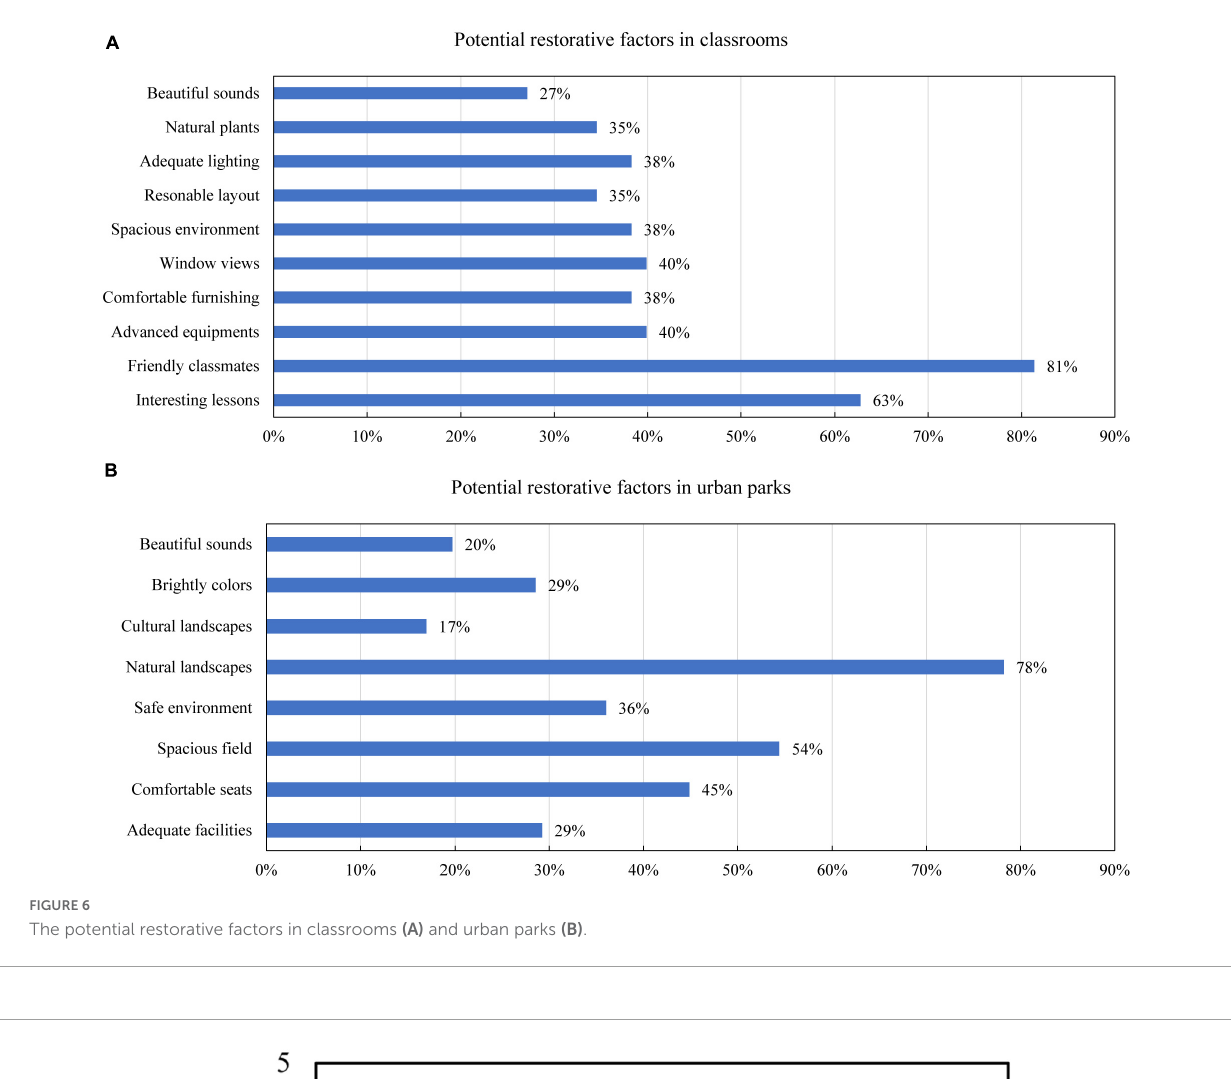
FIGURE6 The potential restorative factors in classrooms (A) and urban parks (B) .